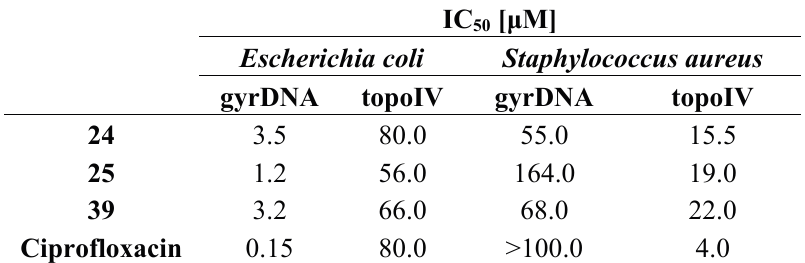
Table 4. Affinity of the selected triazole-CPX hybrids towards bacterial type II topoisomerases obtained from Escherichia coli and Staphylococcus aureus